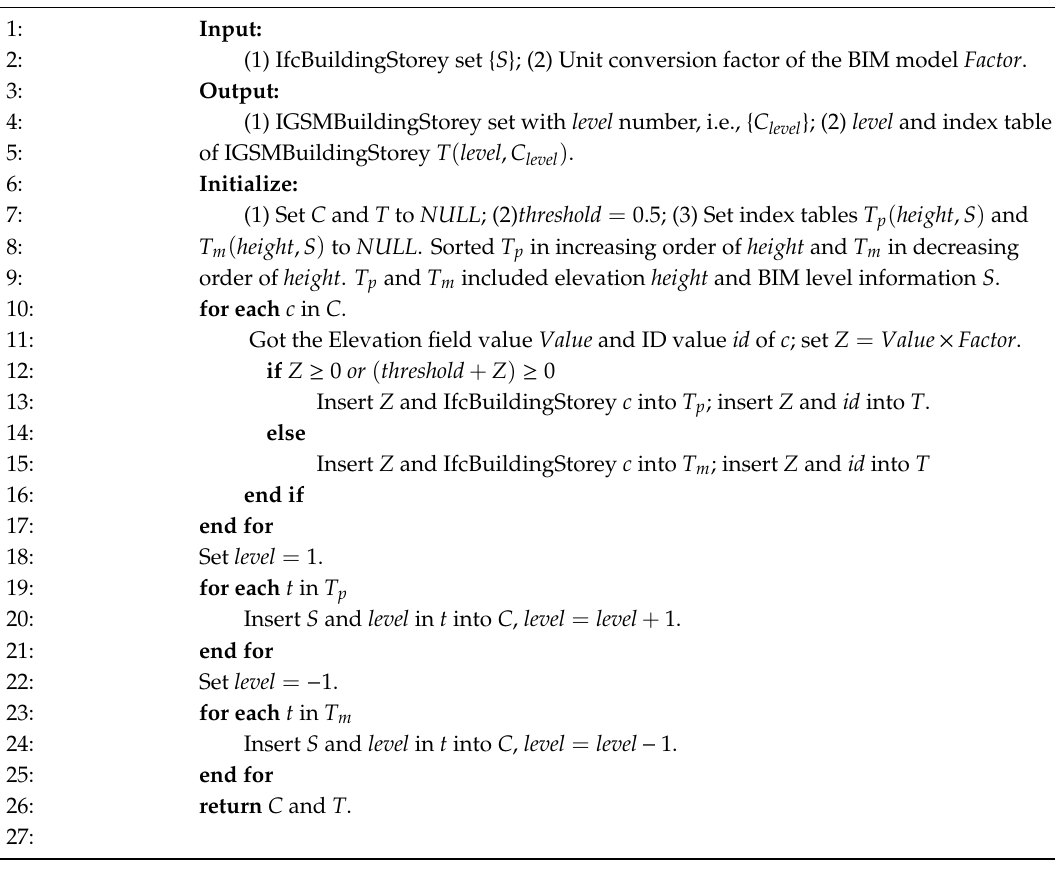
Algorithm 2. Floor Relation Extraction Algorithm